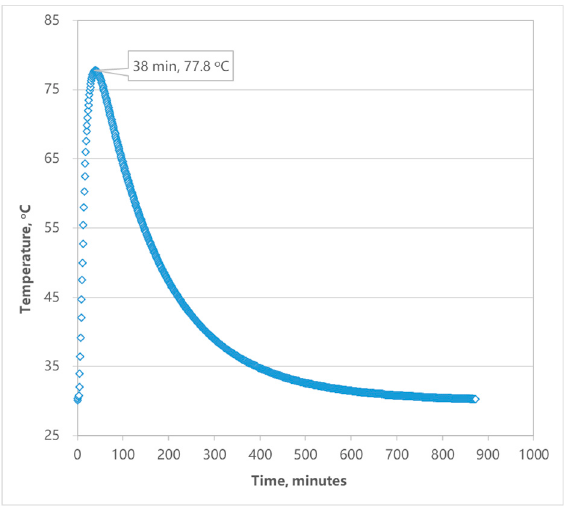
Figure 11. Average temperature of ABS’s surface.